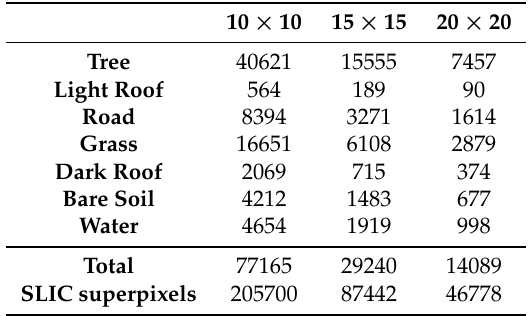
Figure 9. Classification maps based on different superpixels in three scales: ( a ) 10 × 10 SLIC superpixels; ( b ) 10 × 10 Purified SLIC superpixels; ( c ) 10 × 10 Purified all SLIC superpixels; ( d ) 15 × 15 SLIC superpixels; ( e ) 15 × 15 Purified SLIC superpixels; ( f ) 15 × 15 Purified all SLIC superpixels; ( g ) 20 × 20 SLIC superpixels; ( h ) 20 × 20 Purified SLIC superpixels; and ( i ) 20 × 20 Purified all SLIC superpixels. Table 2. Number of SLIC superpixels and selected samples for three